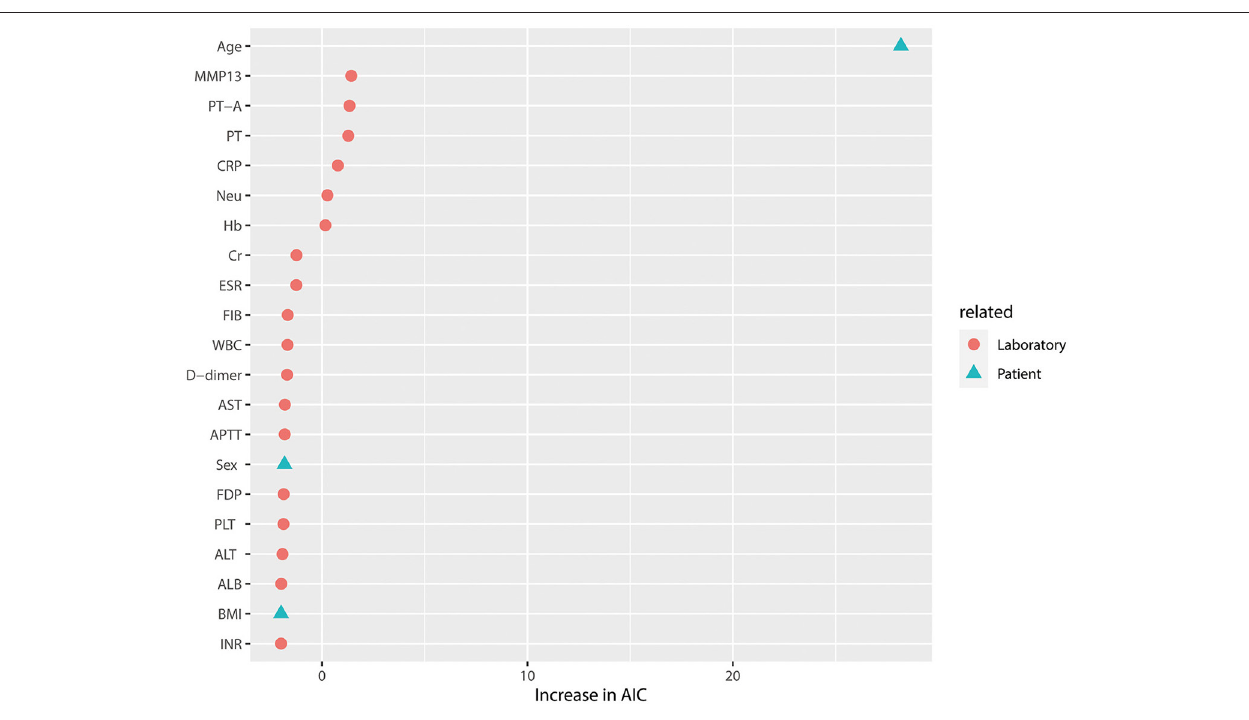
Frontiers in Surgery |